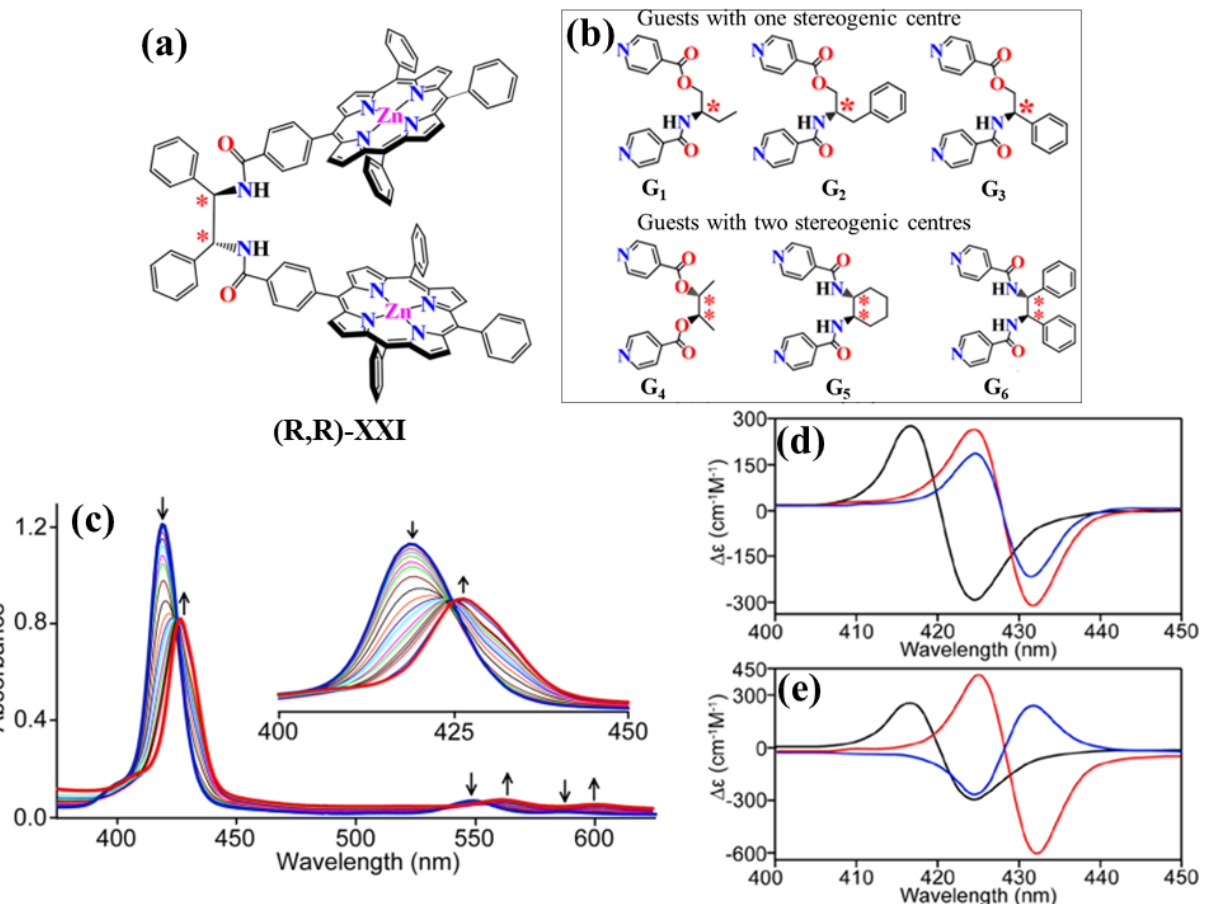
Figure 18. ( a ) Molecular structure of the (R, R)-diphenylethylenediamine bridged Zinc(II) bis-porphyrin tweezer XXI ; ( b ) Structure of the long chiral diamines used in the research. The stereogenic centres are indicated by an asterisk (*); ( c ) UV/Vis titration of (R, R)- XXI with an increasing amount of (R, R)- G 5 in chloroform; ( d ) Circular dichroism spectra of (R, R)- XXI before (black line) and after the addition of (R)- G 1 (red line) and of (S)- G 1 (blue line) in chloroform; ( e ) Circular dichroism spectra of (R, R)- XXI before (black line) and after the addition of (R, R)- G 5 (red line) and of (S, S)- G 5 (blue line) in chloroform. Adapted with permission from reference [81]; published by American Chemical Society